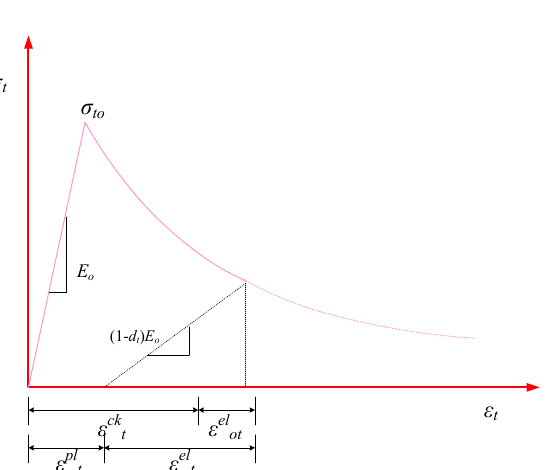
Figure 6. Stress-strain efficiency of HFRGC under tension.